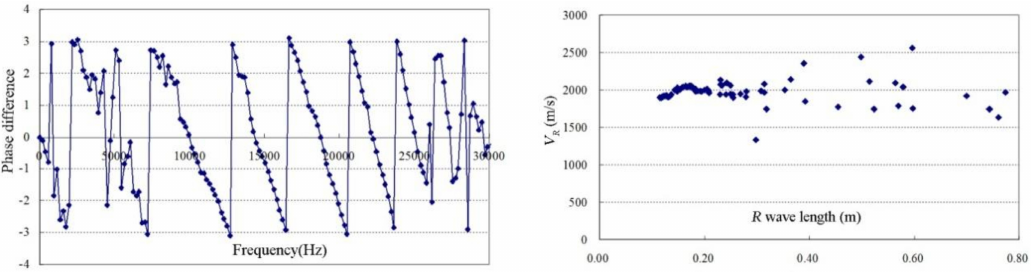
Figure 8. Phase spectrum and dispersion curve of the layered model 2 (concrete-weak interlayer-bedrock).